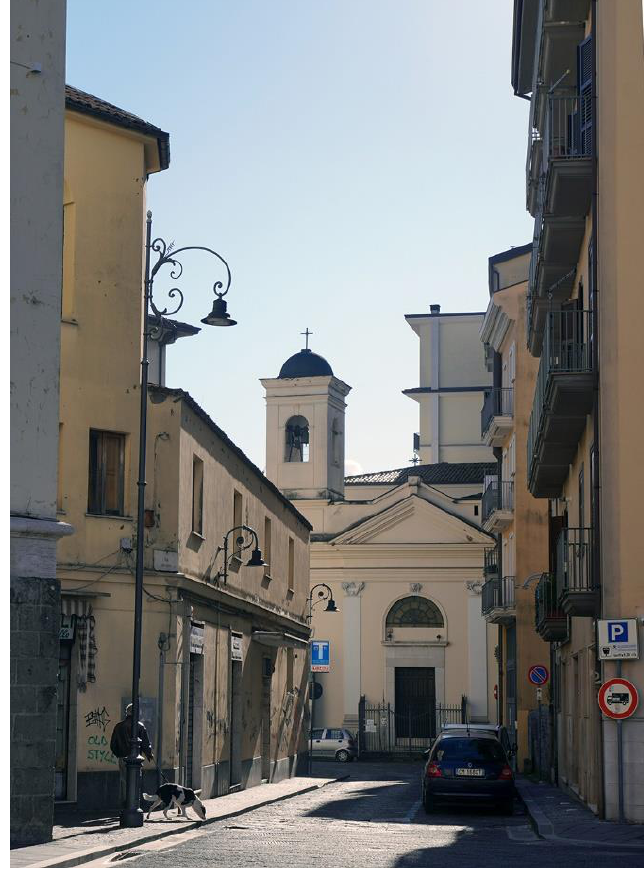
Figure 117. Avellino: Rifugio Street today completely reconstructed (photos by [35,36]).